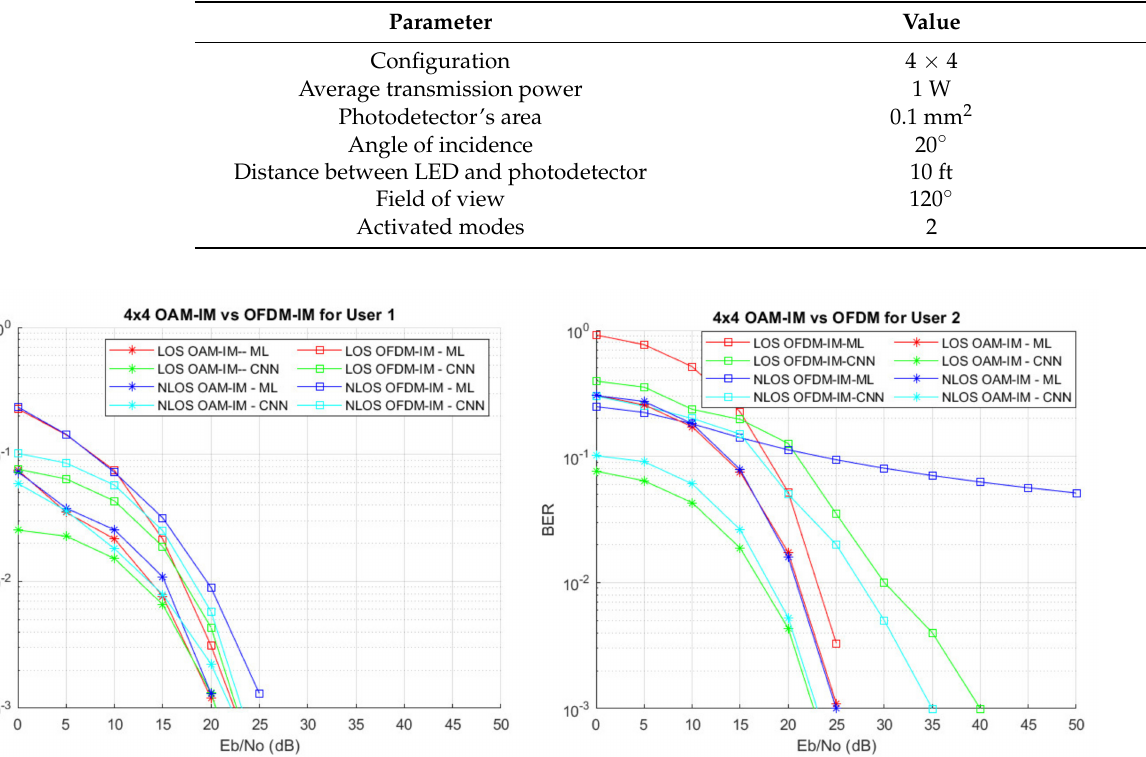
Table 1. Simulation parameters.